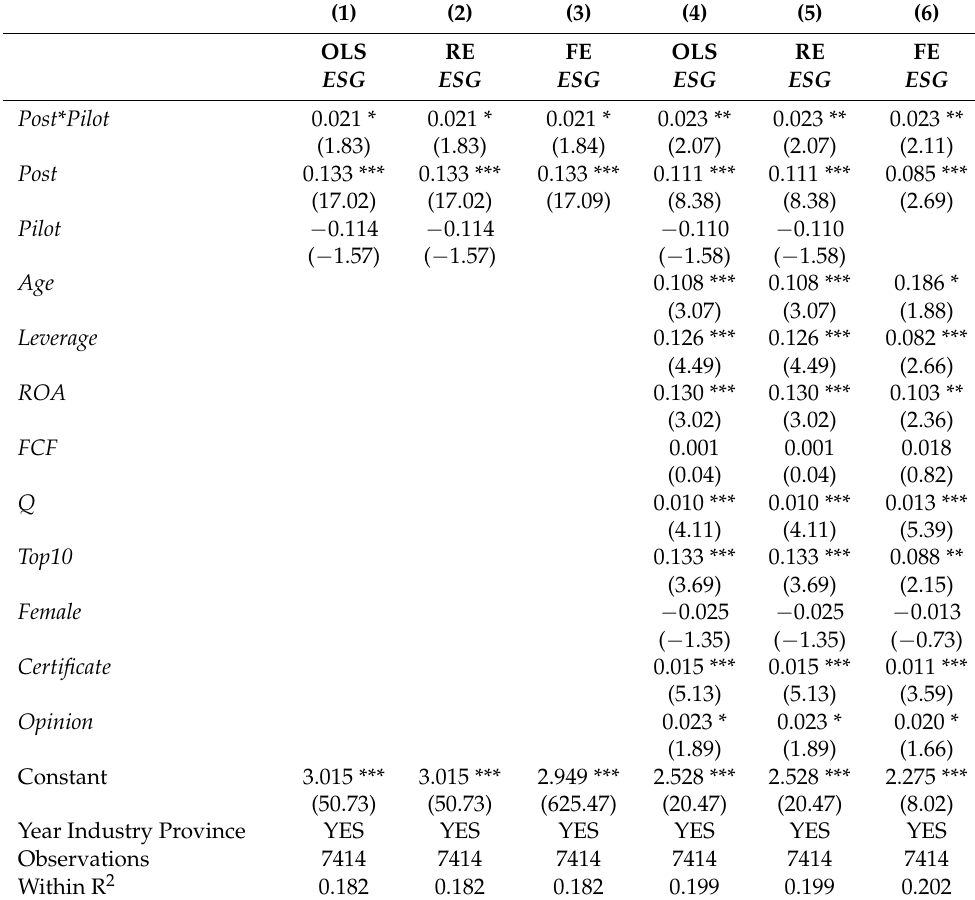
Table 2. DID model regression results of green finance reform on corporate ESG